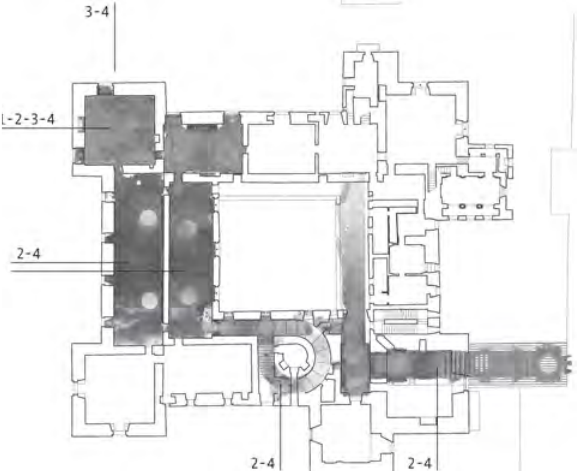
Figure 1. Plan of the documented rooms in the emergency survey